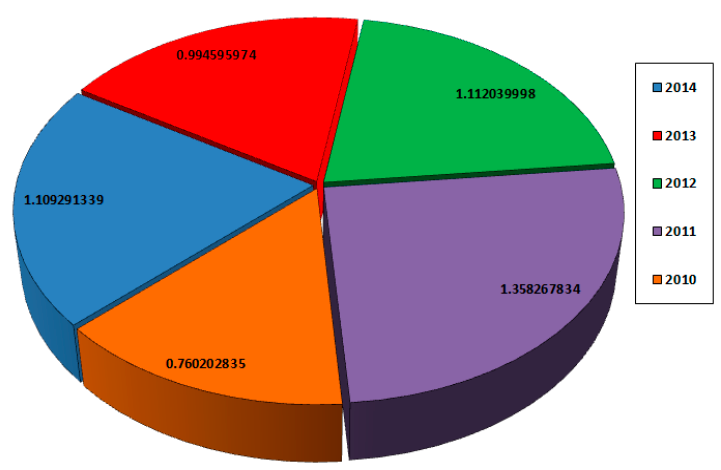
Figure 11. Electrical power output in the north coast of the Atlantic (MW).